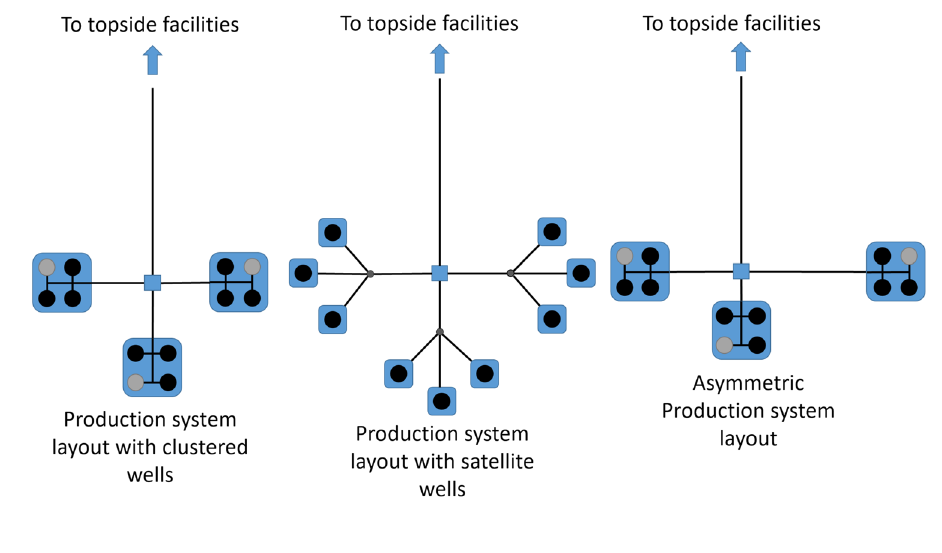
Fig. 8 Decision tree diagram for potential curves